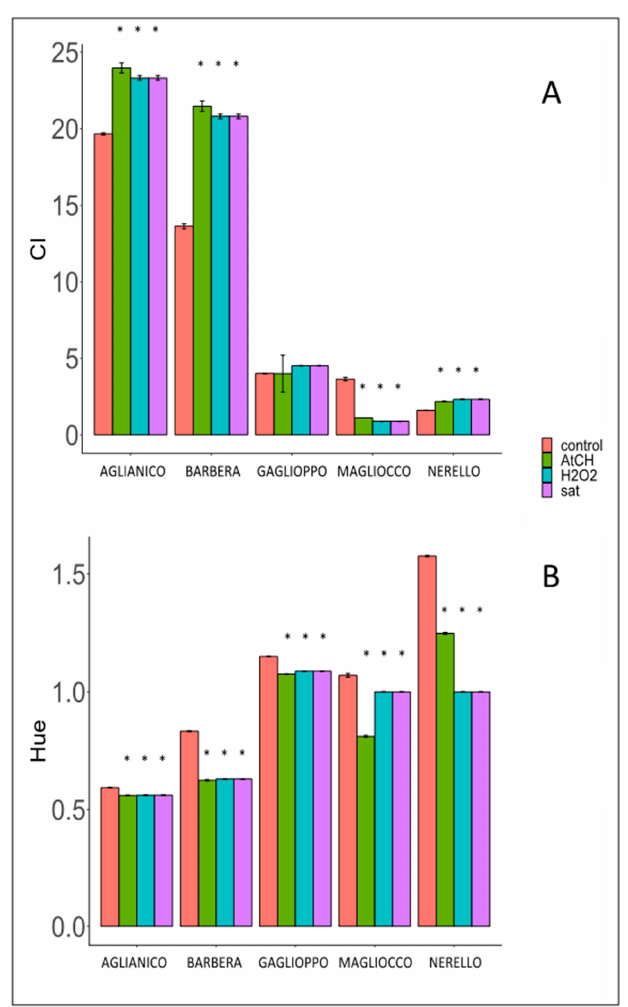
Figure A2. ( A ) Color intensity (CI) and ( B ) hue of wines before and after oxidative treatments. Asterisks (*) indicate significant differences between treated wine and its control ( p -value less than